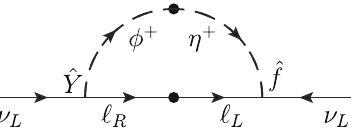
Fig. 1 The one-loop diagram generating neutrino masses